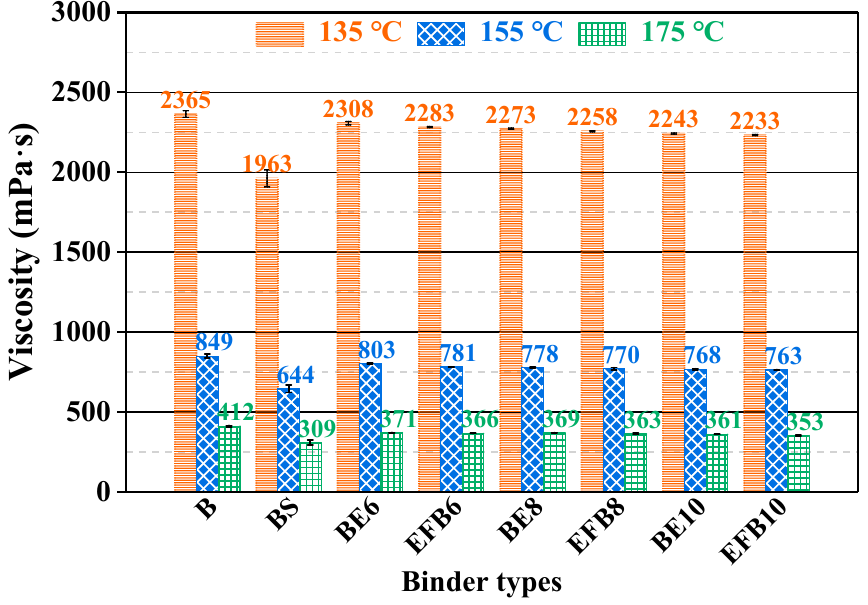
Figure 4. Rotational viscosity test results.